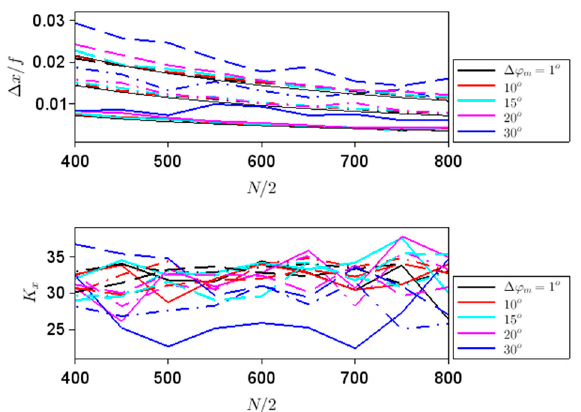
Figure 3. ∆ x (top) and K x (bottom) dependences on aperture size for different steps in ∆ φ m indicated in the legend and focal lengths of f /2 (solid line), f (dashed–dotted line) and 1.5 f (dashed line). The thin black lines in the top figure represent the dependences on N of the function 2 λ / N Λ = λ / NA .